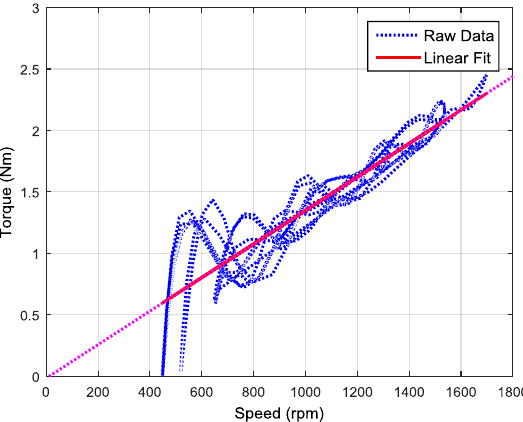
Figure 6. Fitted viscous friction torque based on online pressure and speed measurements.